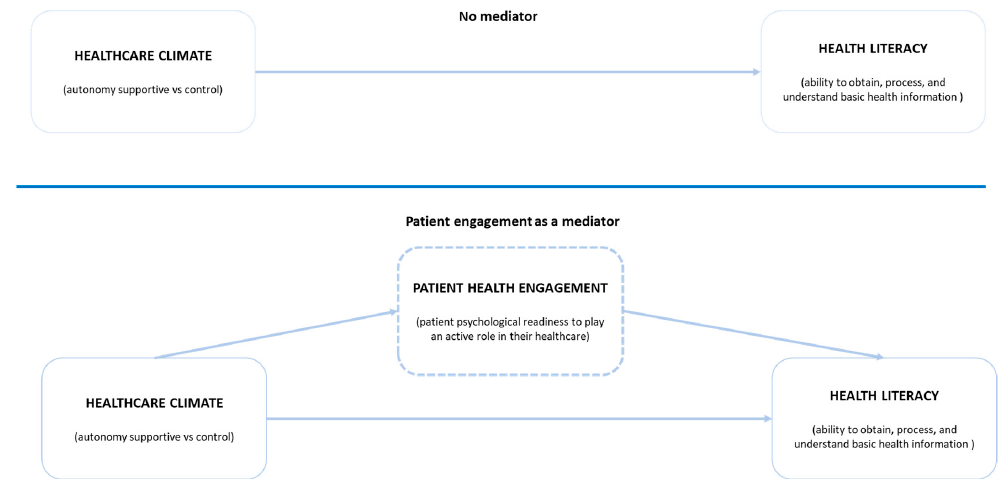
Figure 1. Model: the mediation effect of patient health engagement on healthcare climate in health literacy.